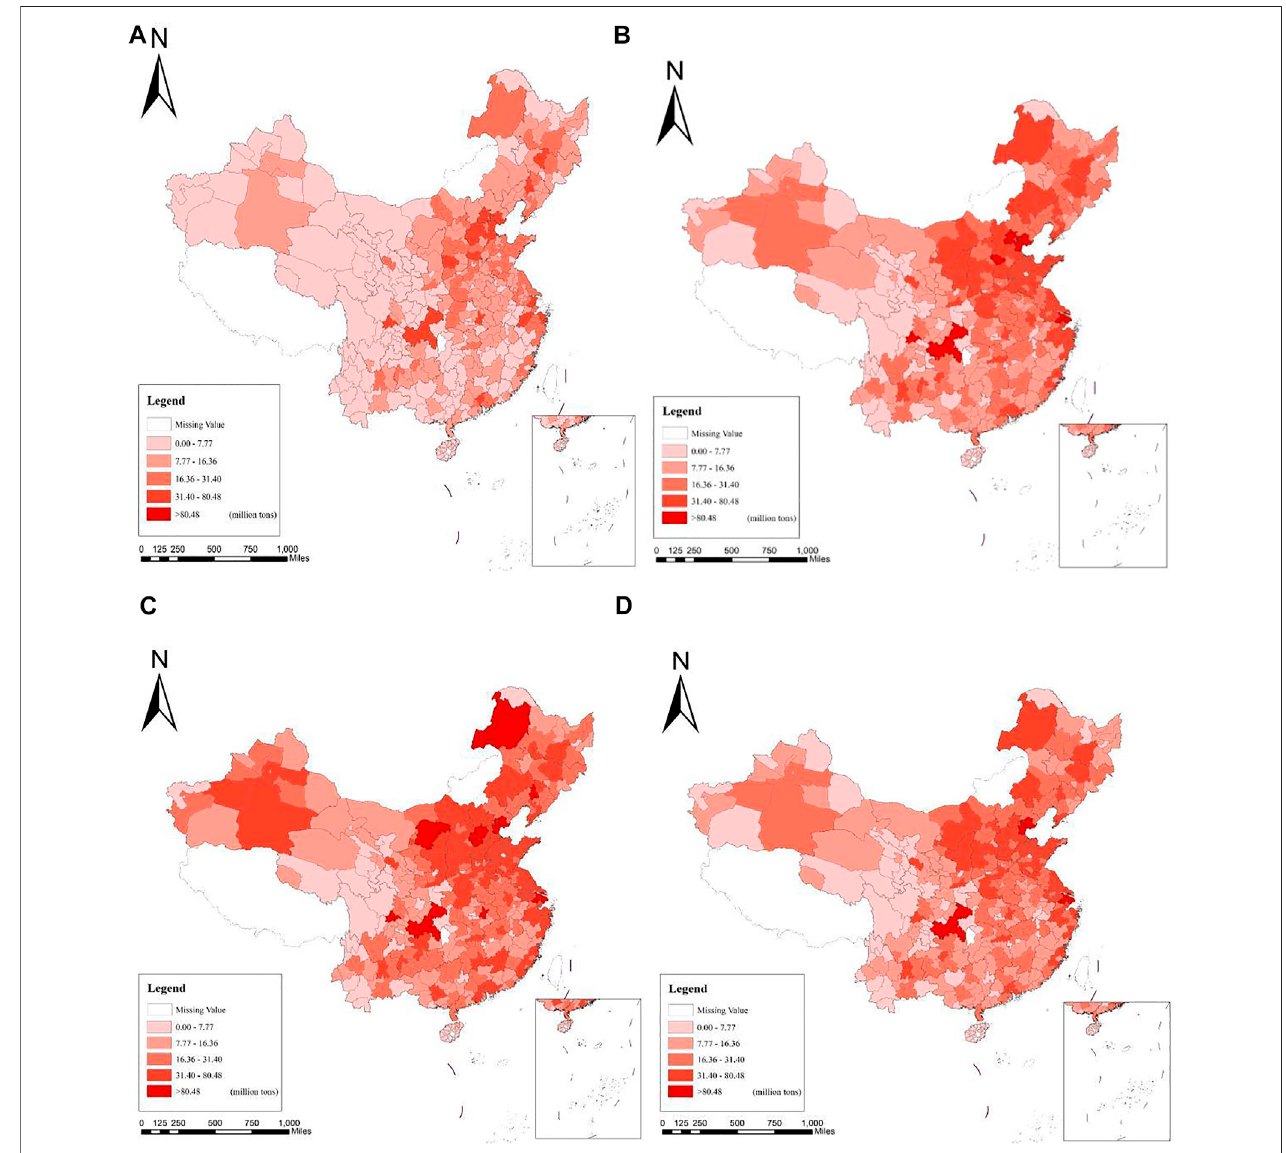
FIGURE 3 | Carbon emissions in Chinese cities based on the nighttime light data. (A) the carbon emissions in 2003; (B) the carbon emissions in 2010; (C) the carbon emissions in 2016; (D) the average carbon emissions from 2003 to 2016.